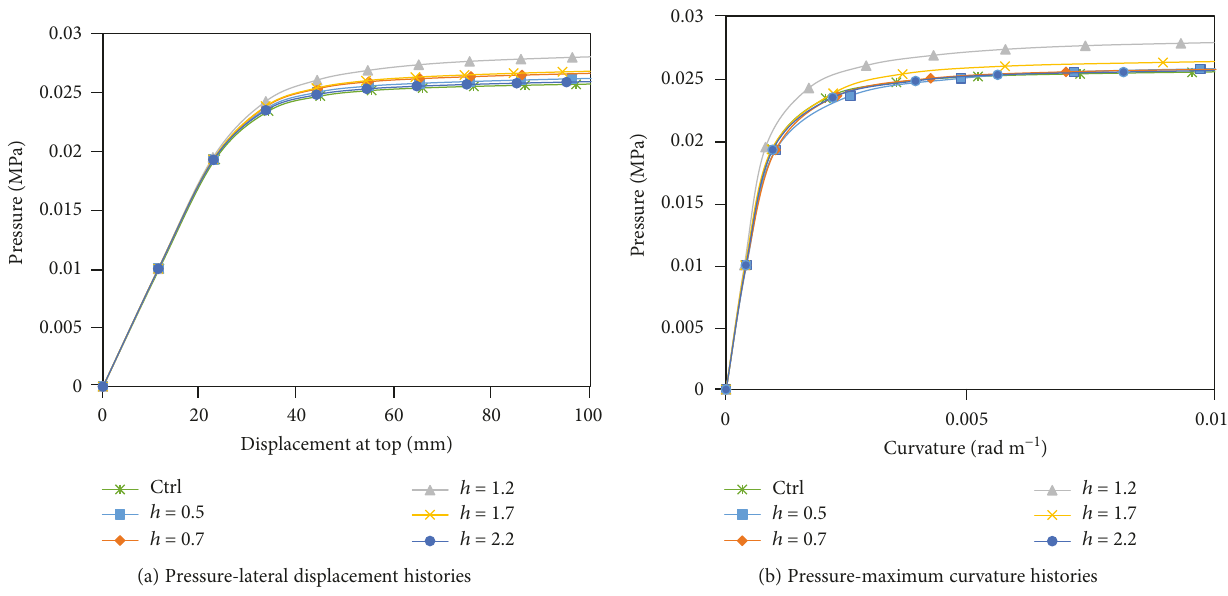
Figure 12: Nonlinear incremental analyses for tree-FRP wrap systems: (a) pressure-lateral displacement histories and (b) pressure-maximum curvature